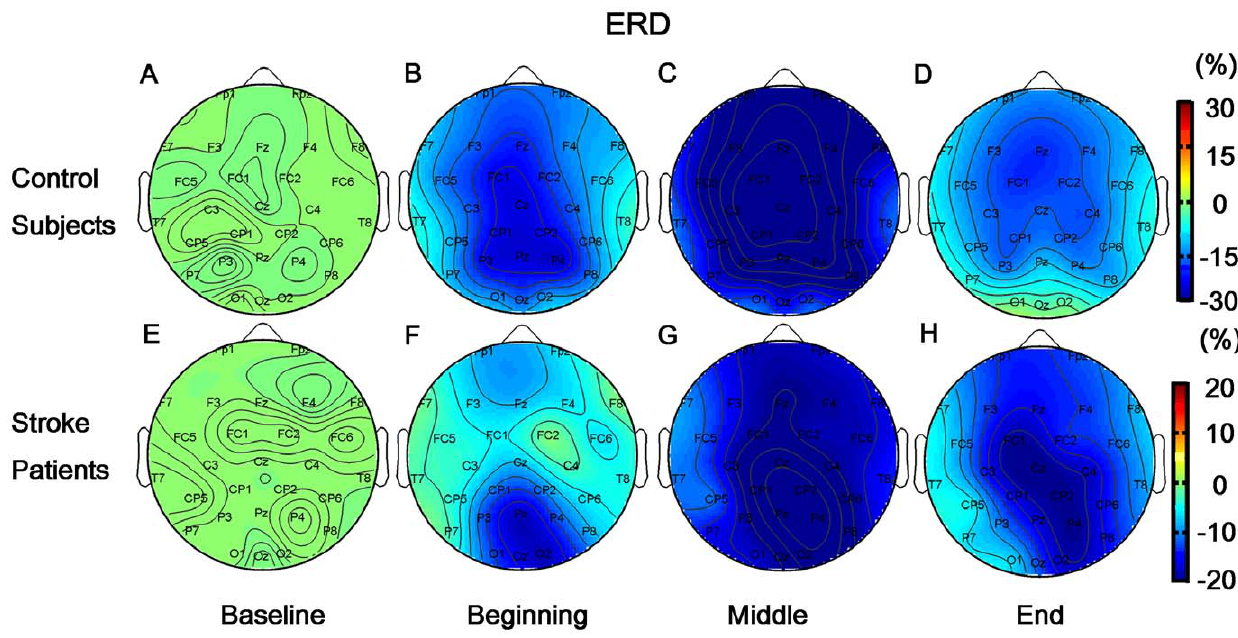
Figure 6. Brain mappings of beta-ERD. A–D: Beta-ERD mapping results for control subjects were shown in four sub-stages. E–H: Beta-ERD mapping results for stroke patients were illustrated which were corresponding to four sub-stages respectively. All other three sub-stages had lower ERD than Baseline, and deeper blue color represented higher phase-unlocked activation (i.e., more negative compared with Baseline). doi:10.1371/journal.pone.0042922.g006 was independent of the stimulus parity of HAND (p =0.190, Figure 5B). Further, both main effect of ANGLE (F(5,100)= 3.916, p= 0.003) and its interaction with GROUP were significant (F(5,100)= 2.653, p = 0.027). Interestingly, ‘‘an-